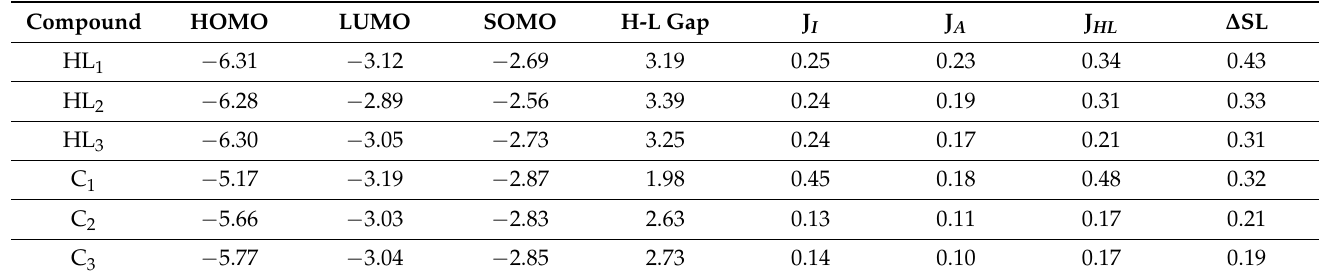
Table 6. Frontier Orbital Energies, HOMO-LUMO Gap and the KID Descriptors of the Ligand Descriptors and their Ni(II)